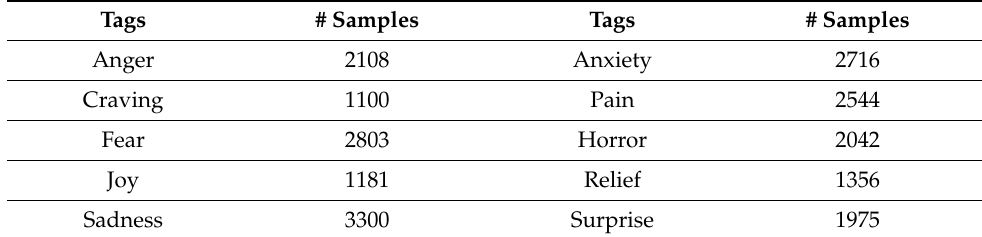
Table 5. Statistics of the dataset for task